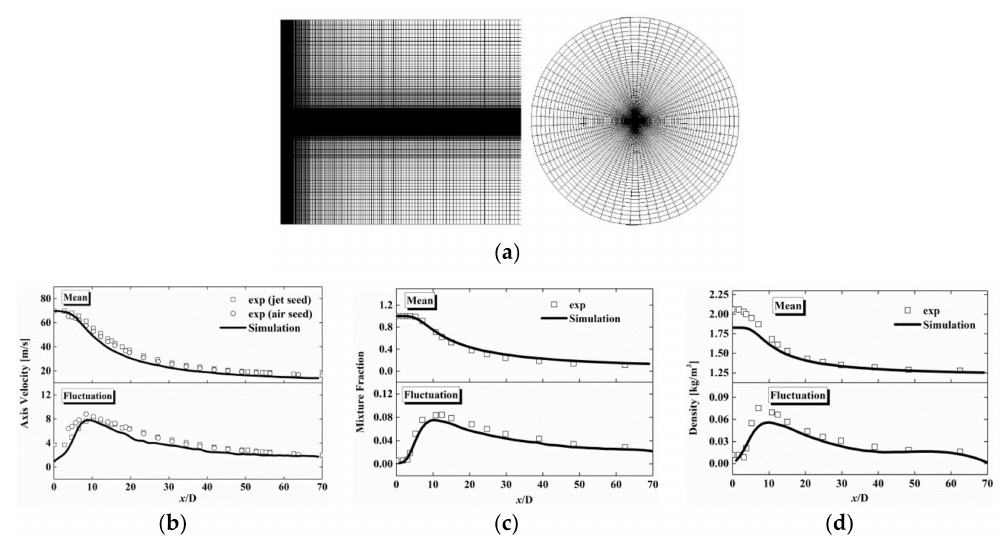
Figure 4. ( a ) Computational grid and simulation results of the major quantities along the centerline: ( b ) velocity of u ; ( c ) mixture fraction; and ( d )